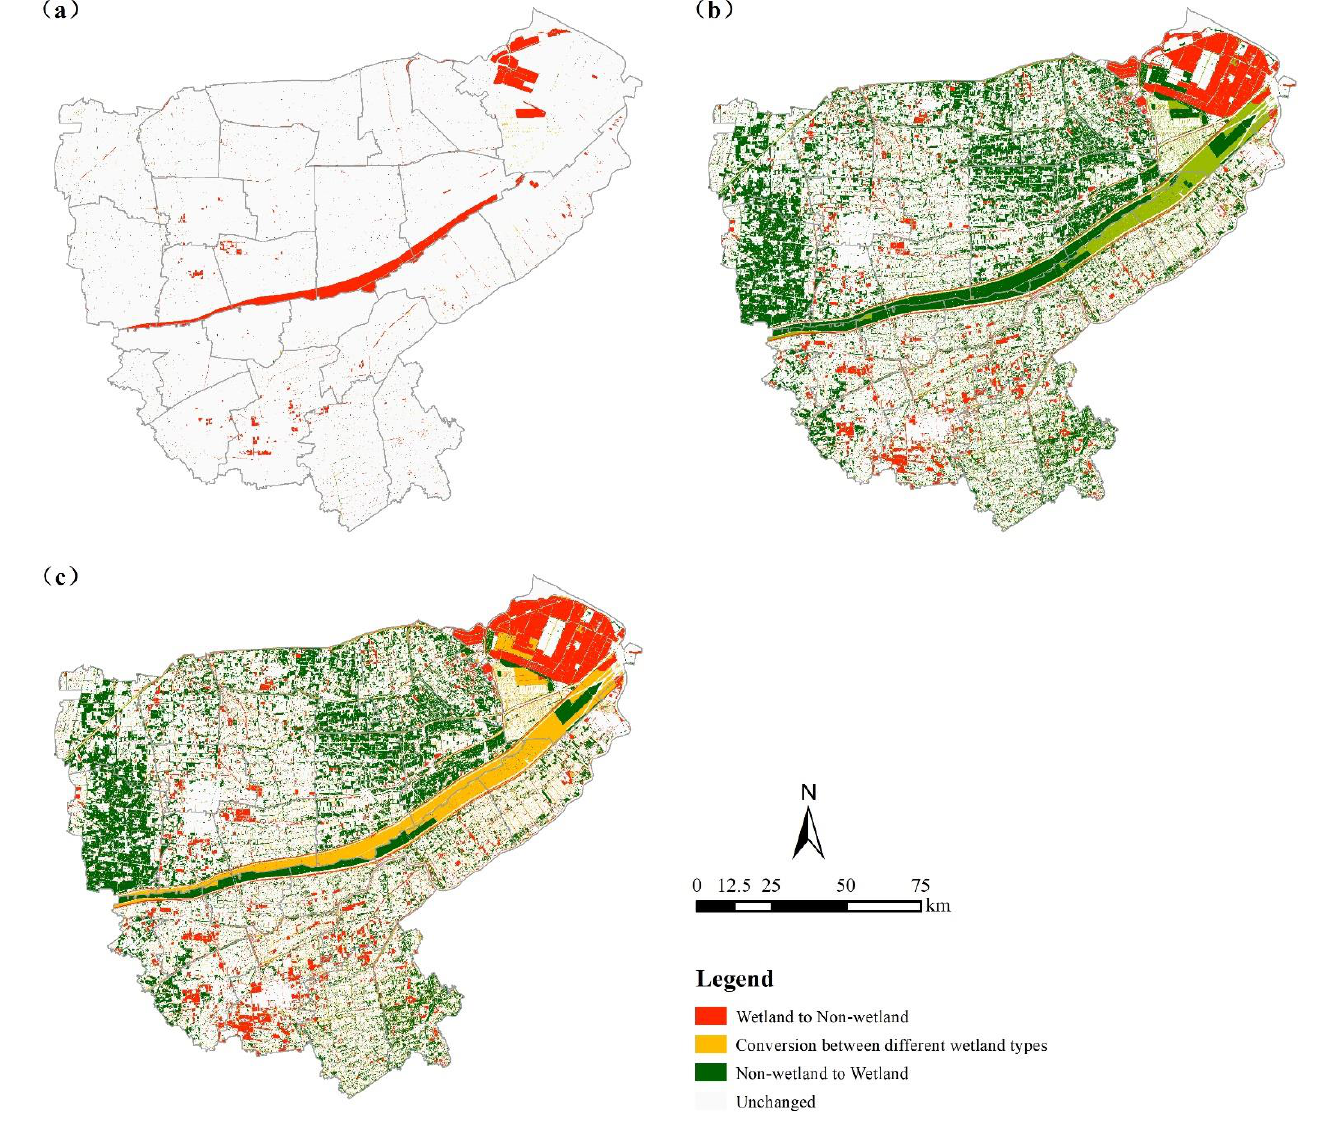
Figure 5. Landscape conversion matrix of different years: ( a ) 2009 – 2014; ( b ) 2014 – 2020; ( c ) 2009 –